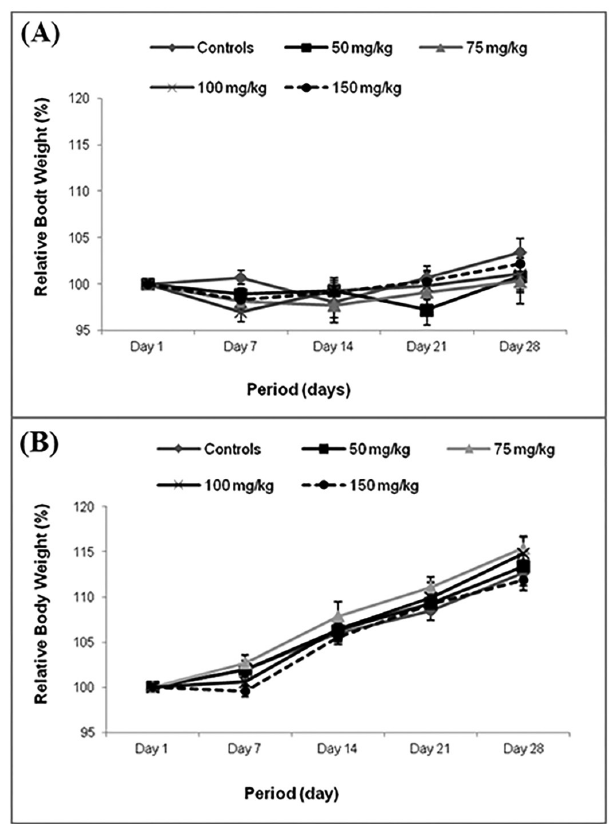
FIGURE 1 - Relative body weight gain in Wistar rats male (A) and female (B) after oral treatment for 28 consecutive days with p -synephrine associated to ephedrine, salicin and caffeine (10:4:6:80 w/w). Each point represent the mean ± standard error of the mean